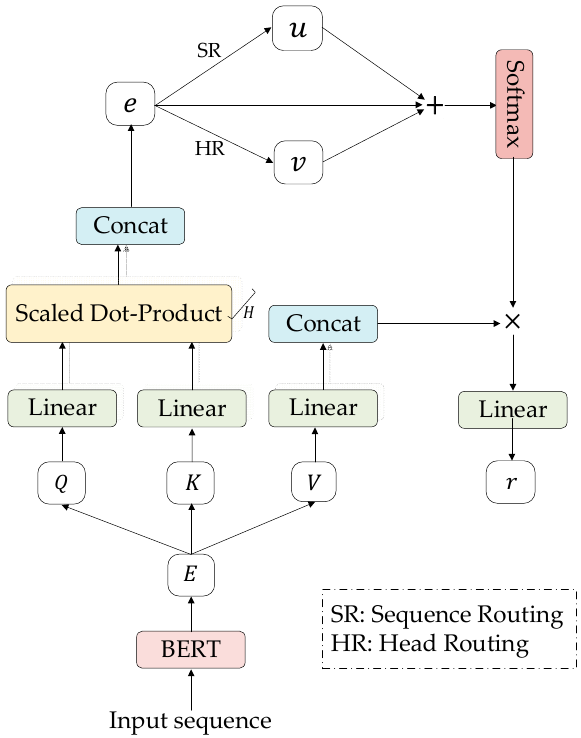
Figure 2. The architecture of each module in BiCapAtt.